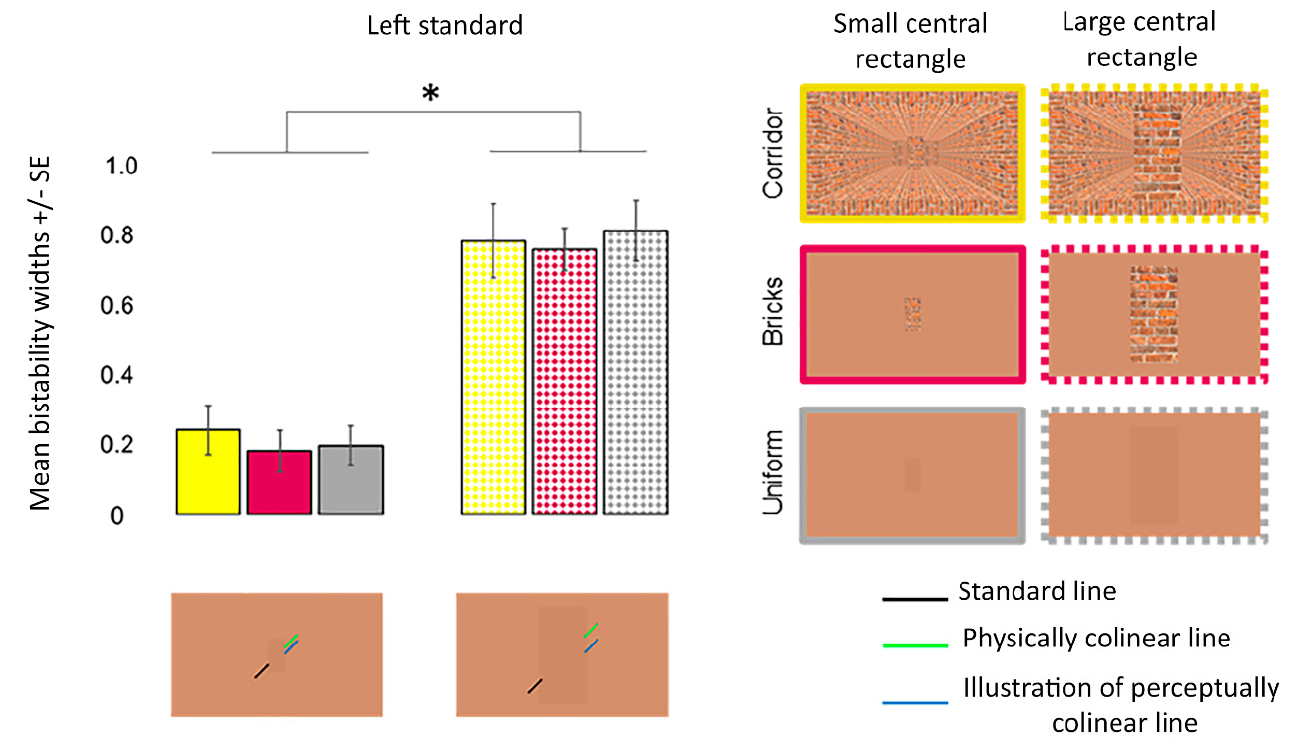
Figure 10. Mean bistability widths for the different conditions in experiment 3. The asterisk (*) denotes the difference between the perceptual uncertainty produced by the large and small central rectangles at p < 0.050. Mean bistability widths were computed by subtracting P = 0.25 from P = 0.75. Error bars denote standard errors for within-subject contrasts as described by O’Brien and Cousineau [22] .